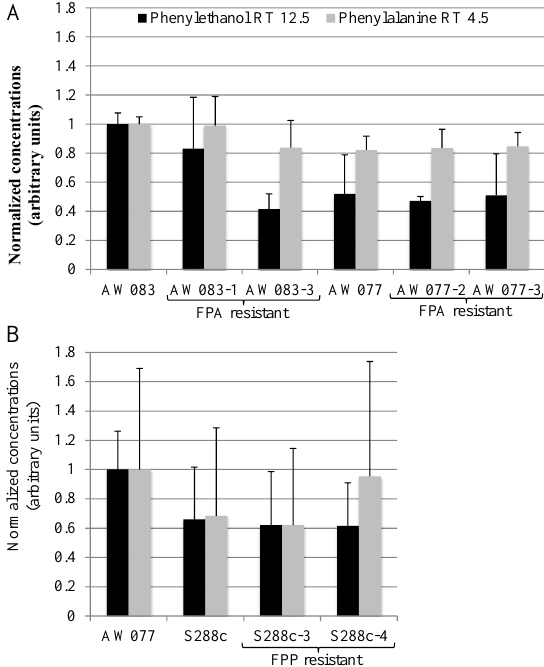
Figure 9. FPP or FPA resistance is not sufficient for increased phenylethanol production. Strains were incubated in medium containing phenylalanine as the source of nitrogen for three days, and then phenylethanol and phenylalanine concentration in the medium were measured using GC-MS. Each strain’s production of phenylethanol or phenylalanine was normalized to 1 using ( A ) AW083 strain or ( B ) AW077 strain. The average and standard deviation of three independent trials is shown.